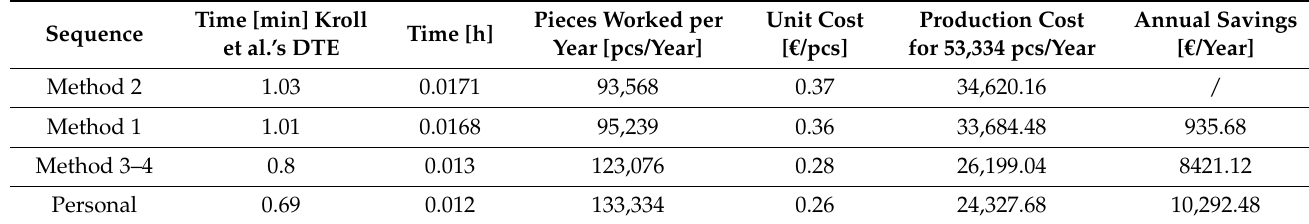
Table 6. DTE with the Desai and Mital